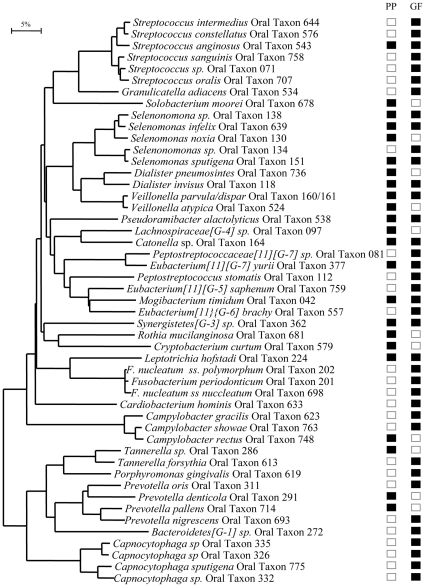
Phylogenetic analysis of bacterial species/phylotypes contributing to species/phylotype diversity in GCF samples and PP samples.The species/phylotypes with statistically significant PLS regression coefficients >0.02 or <−0.02 (data from Figure 2B for the GCF samples and from Figure 5 for the PP samples) were selected for the phylogenetic analysis. The marker bar represents 5% difference in nucleotide sequences. GF abbreviation for gingival crevicular fluid and PP for subgingival paper point samples. Black boxes indicate presence and white boxes absence of the depicted species/phylotype.